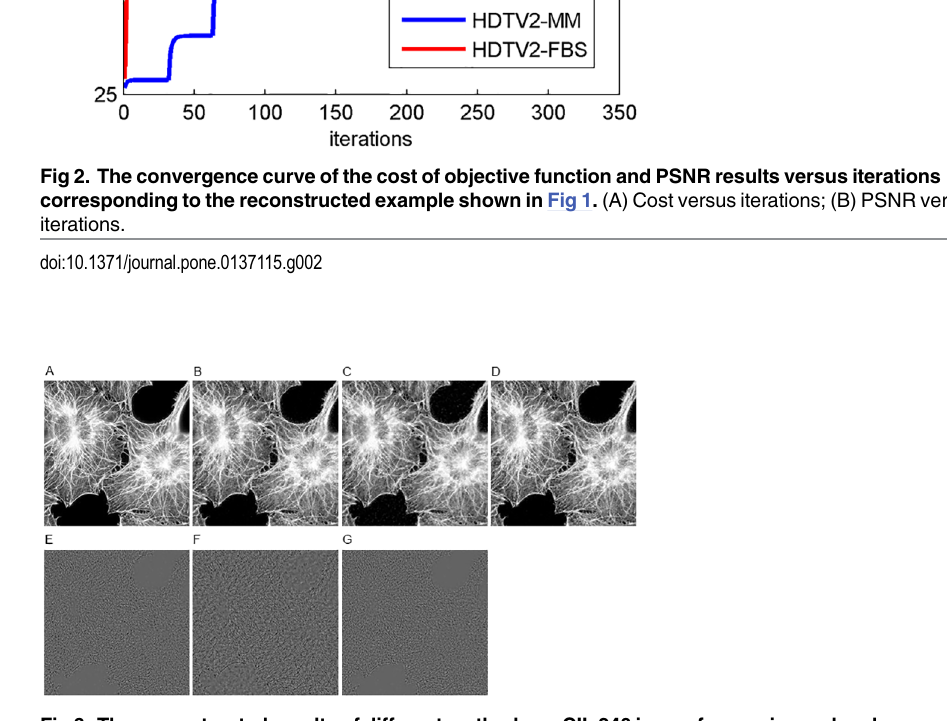
Fig 3. The reconstructed results of different methods on CIL 240 image from noisy and undersampled Fourier data (noise level: 30 dB and sampling ratio: 30%). (A) Original image; (B) TV-FISTA result; (C) HDTV2-MM result; (D) HDTV2-FBS result; (E) the residual of TV-FISTA result; (F) the residual of HDTV2-MM result; (G) the residual of HDTV2-FBS result.